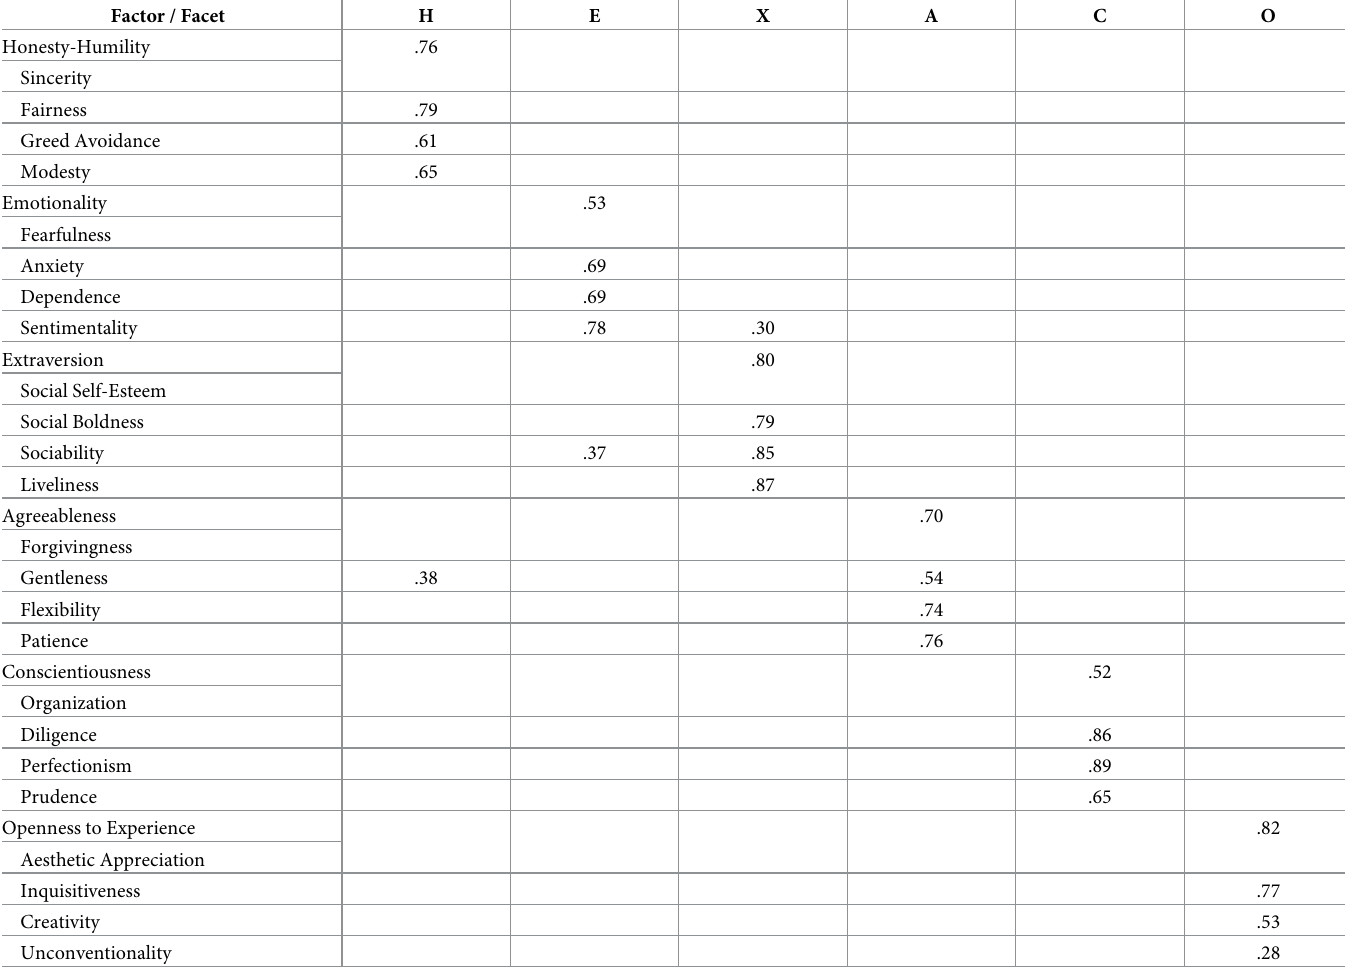
Table 4. Factor loadings of the 6-factor CFA on the facets of the 192-item HEXACO-MSI-E (Study 2). Factor / Facet